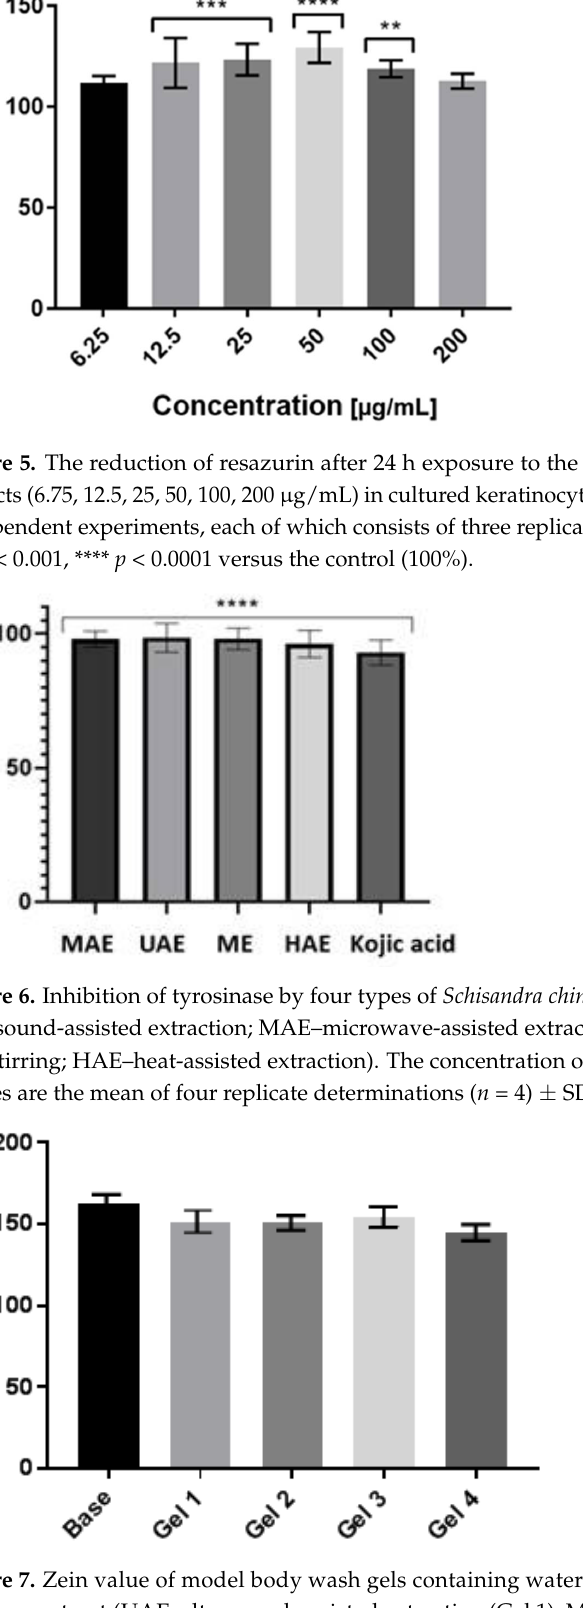
Figure 7. Zein value of model body wash gels containing water S. chinensis extracts. Four types